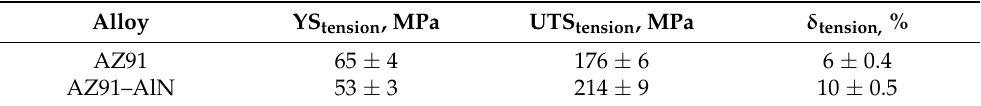
Table 2. Mechanical properties of AZ91 magnesium alloys after tensile